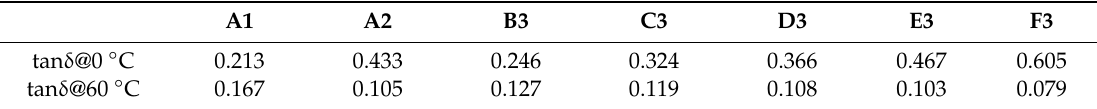
Table 4. tan δ at 0 °C and 60 °C of E25-SSBR/BR composites with different ratio of ESSBR/SSBR.